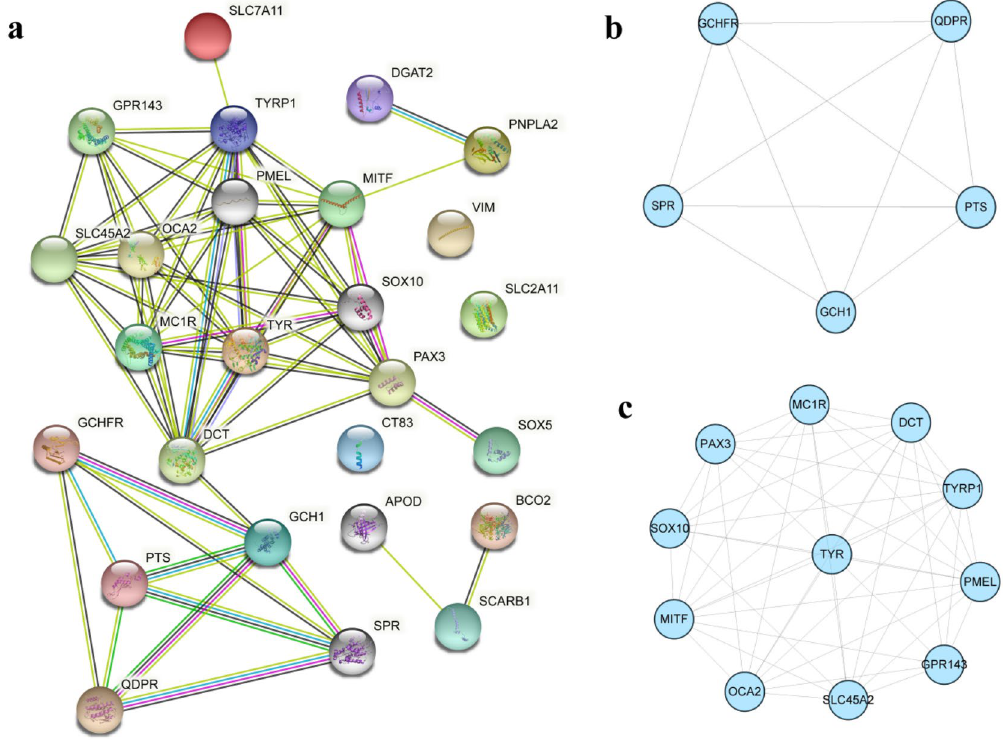
Figure 8. PPI network analysis of the pigmentation-related genes based on STRING database. ( a ) Overall PPI network of the pigmentation-related genes identified in this study. ( b ) Module associated with xanthophores. ( c ) Module associated with